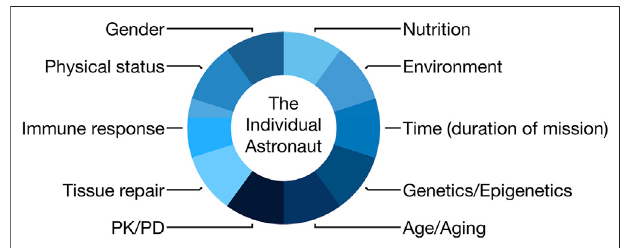
FIGURE 1 | Scheme demonstrating the components of an astronaut that would need tobe considered in anindividualized medicine approach (PK, pharmacokinetics; PD,